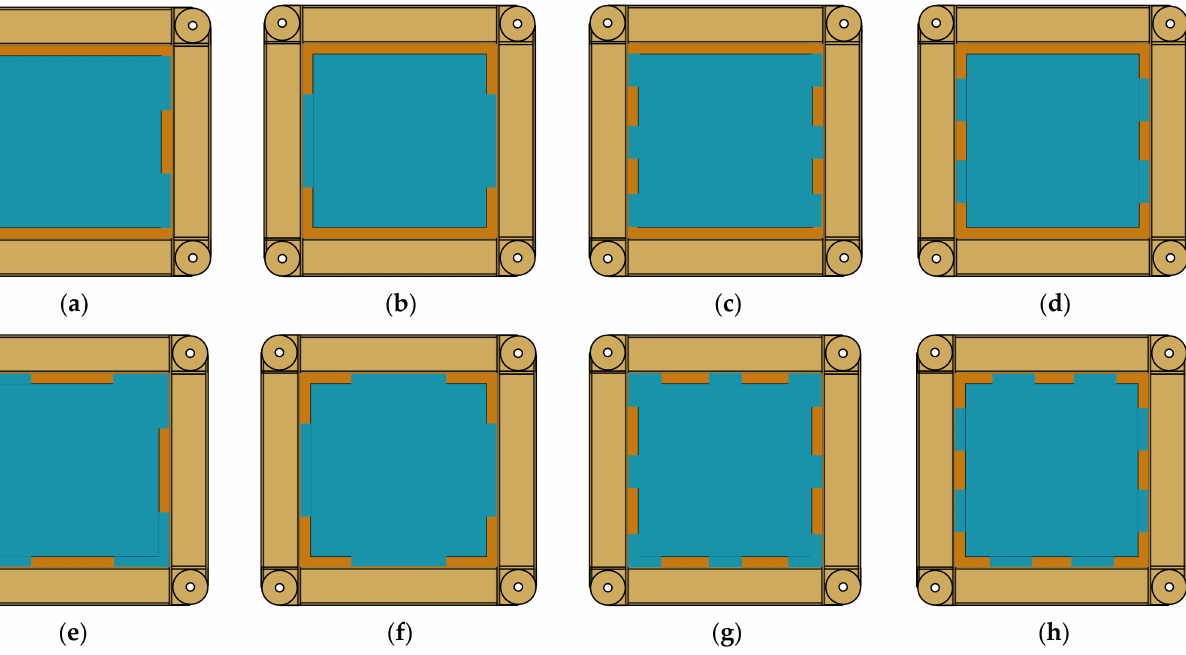
Figure 7. Different types of infill plate-to-frame connection: ( a ) S1; ( b ) S1R; ( c ) S2; ( d ) S2R; ( e ) S3; ( f ) S3R; ( g ) S4; ( h ) S4R.